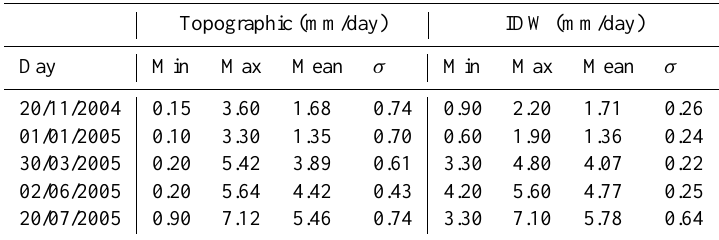
Fig. 9. Daily differences between mean ET 0 estimates at watershed scale with global radiation IDW interpolated and topographically corrected (ET 0IDW –ET 0Top ) . Table 6. Maximum, minimum, mean and standard deviation (mm/day) of daily evapotranspiration estimates in the watershed on selected days with global radiation topographically corrected and IDW